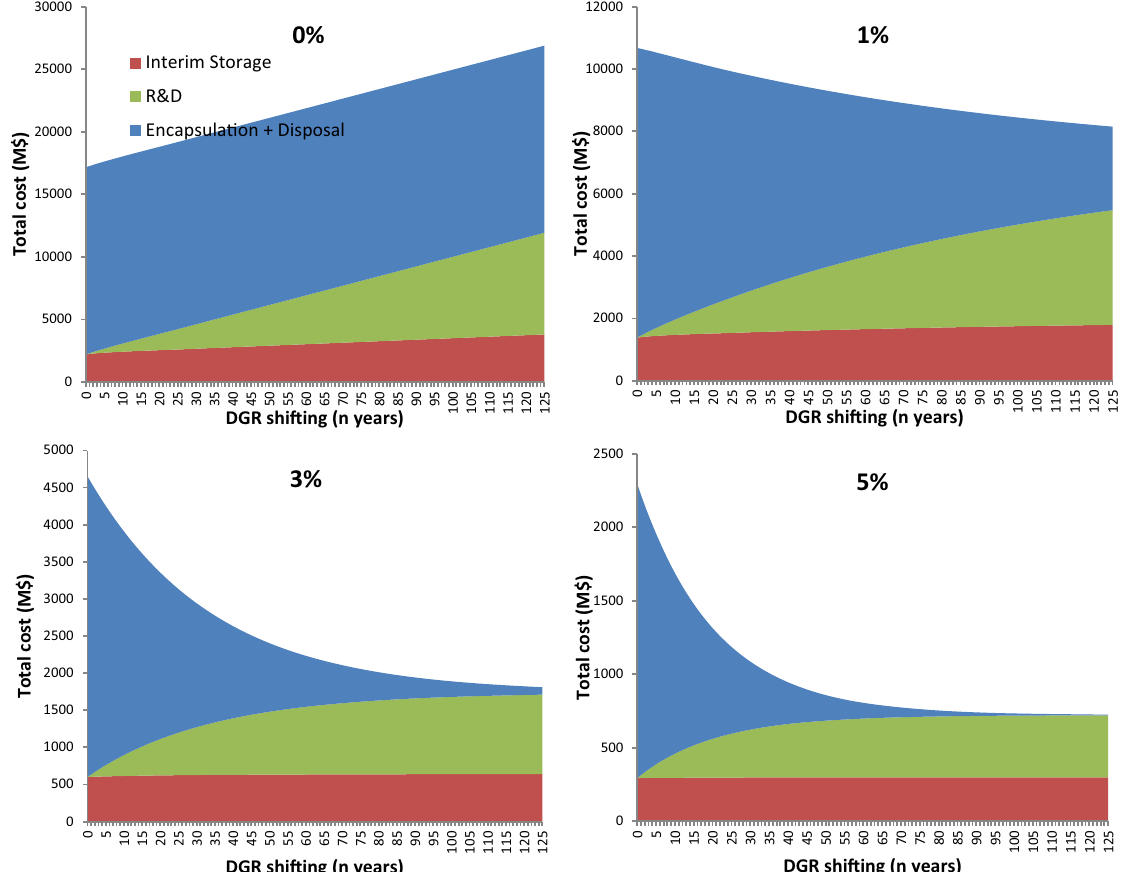
Fig. 9. Effect of rescheduling DGR deployment with the same initial operating period for n years with different discount rates (for countries with research laboratories).